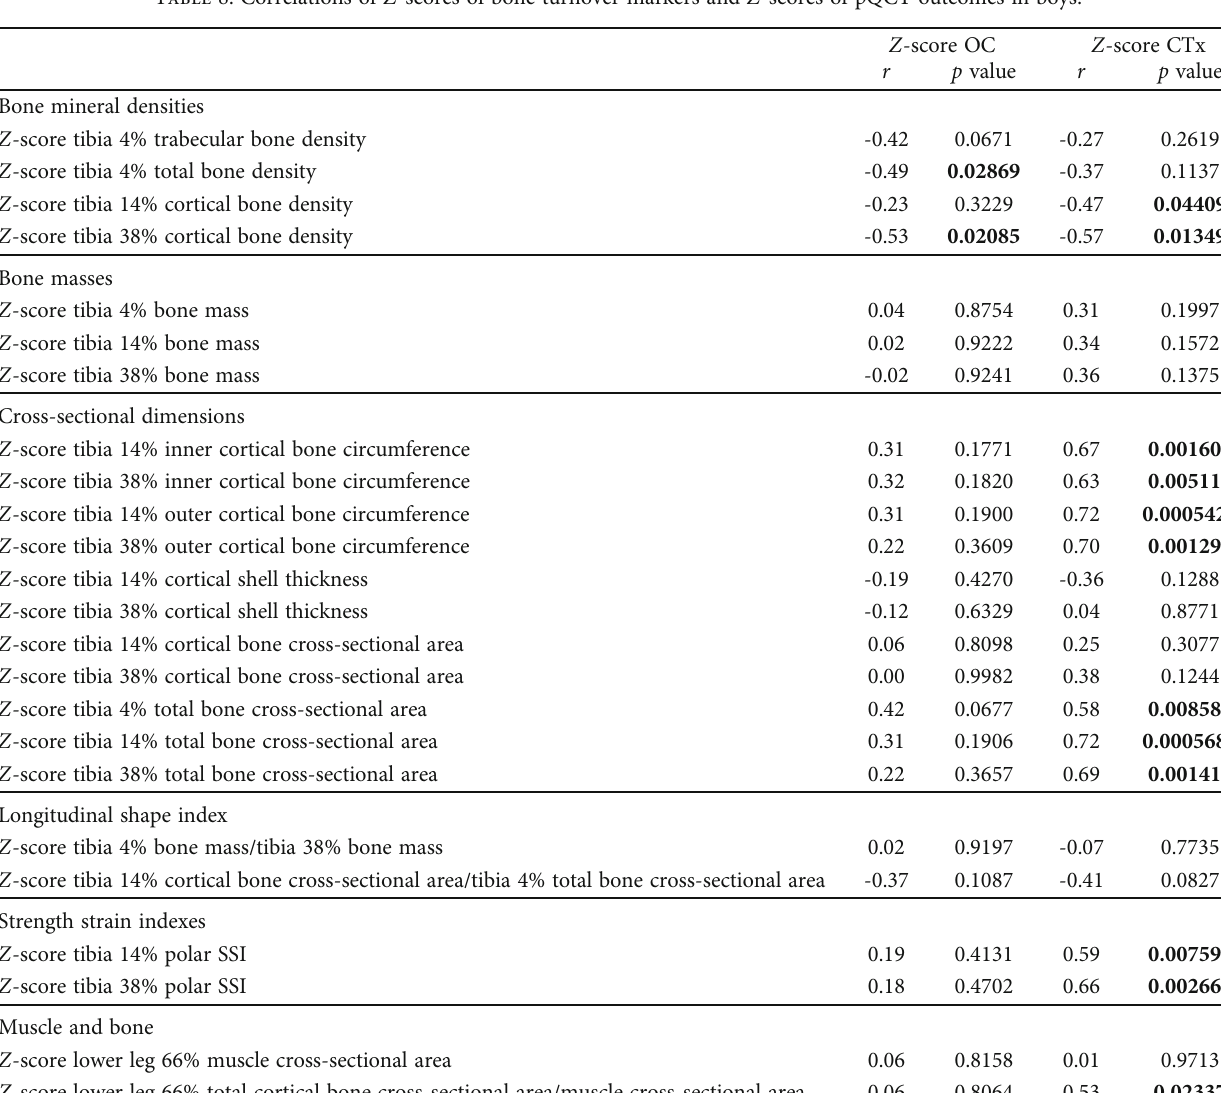
Table 8: Correlations of Z -scores of bone turnover markers and Z -scores of pQCT outcomes in boys.